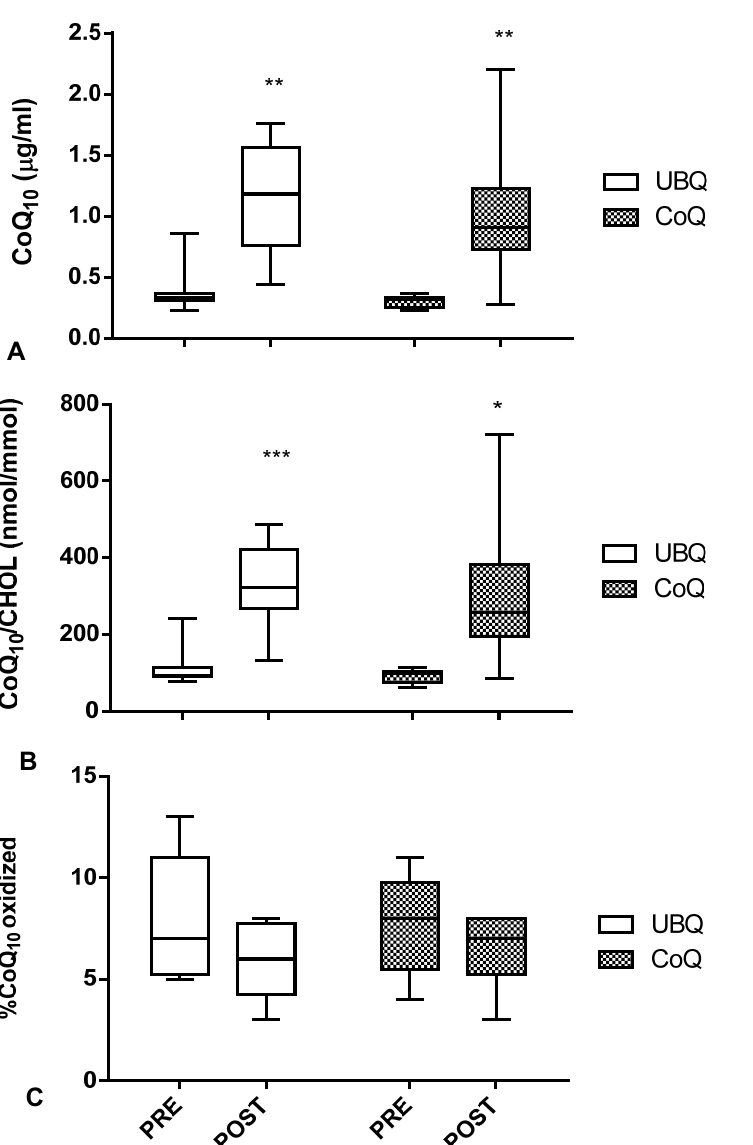
Figure 3. Plasma CoQ 10 levels. ( A ) CoQ 10 normalized to cholesterol (CHOL) levels ( B ) and percent of oxidized CoQ 10 ( C ) in human healthy volunteers supplemented for 2 weeks with UBQ and crystalline CoQ 10 (CoQ) at the same dose (i.e., 100 mg/day of CoQ 10 ). Data are expressed as boxes and bar plots (mean value) ( n = 8). Statistical significance was calculated using unpaired t -tests with Welch’s correction compared with pre-supplementation (PRE) (* p < 0.05, ** p < 0.01, *** p < 0.001).